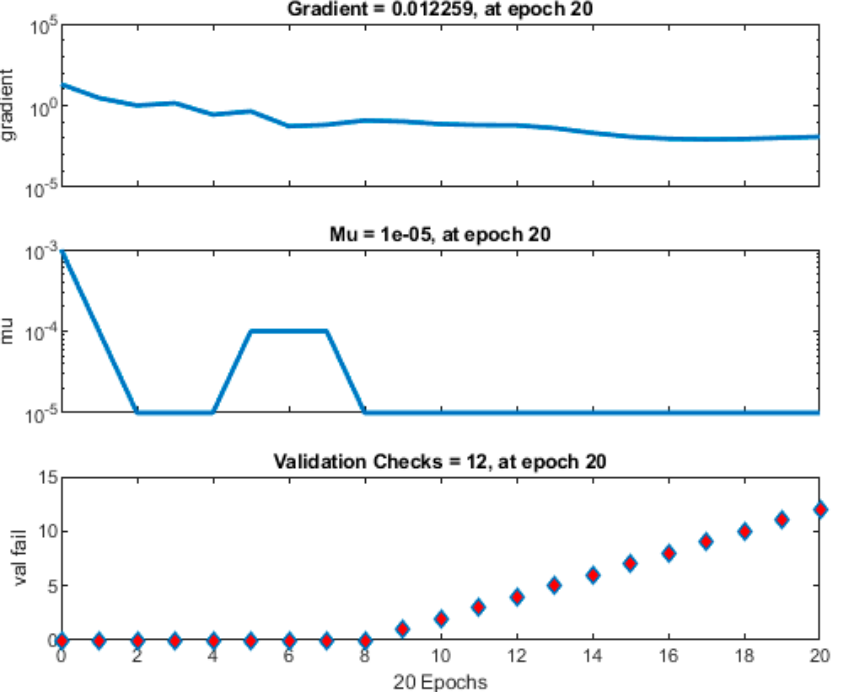
Figure 10. Gradient, momentum, validation checks values obtained during the learning process for the best analyzed neural network.